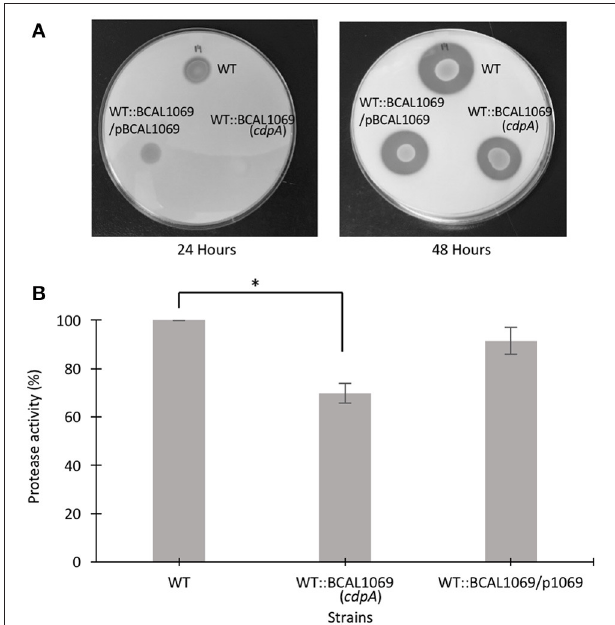
FIGURE 6 | Protease activity of B. cenocepacia K56-2 WT, WT::BCAL1069 c-di-GMP mutant and complemented mutant. (A) Protease activity of strains on 2% skim milk agar plates after 24 and 48h at 37 ◦ C. One representative of four independent experiments is shown. (B) Quantitative analysis of proteolytic activity after 48h on 2% skim milk agar plates. Protease activity is represented in percentage relative to the WT strain. The protease assay was performed four times independently with three technical replicates per experiment (* p <